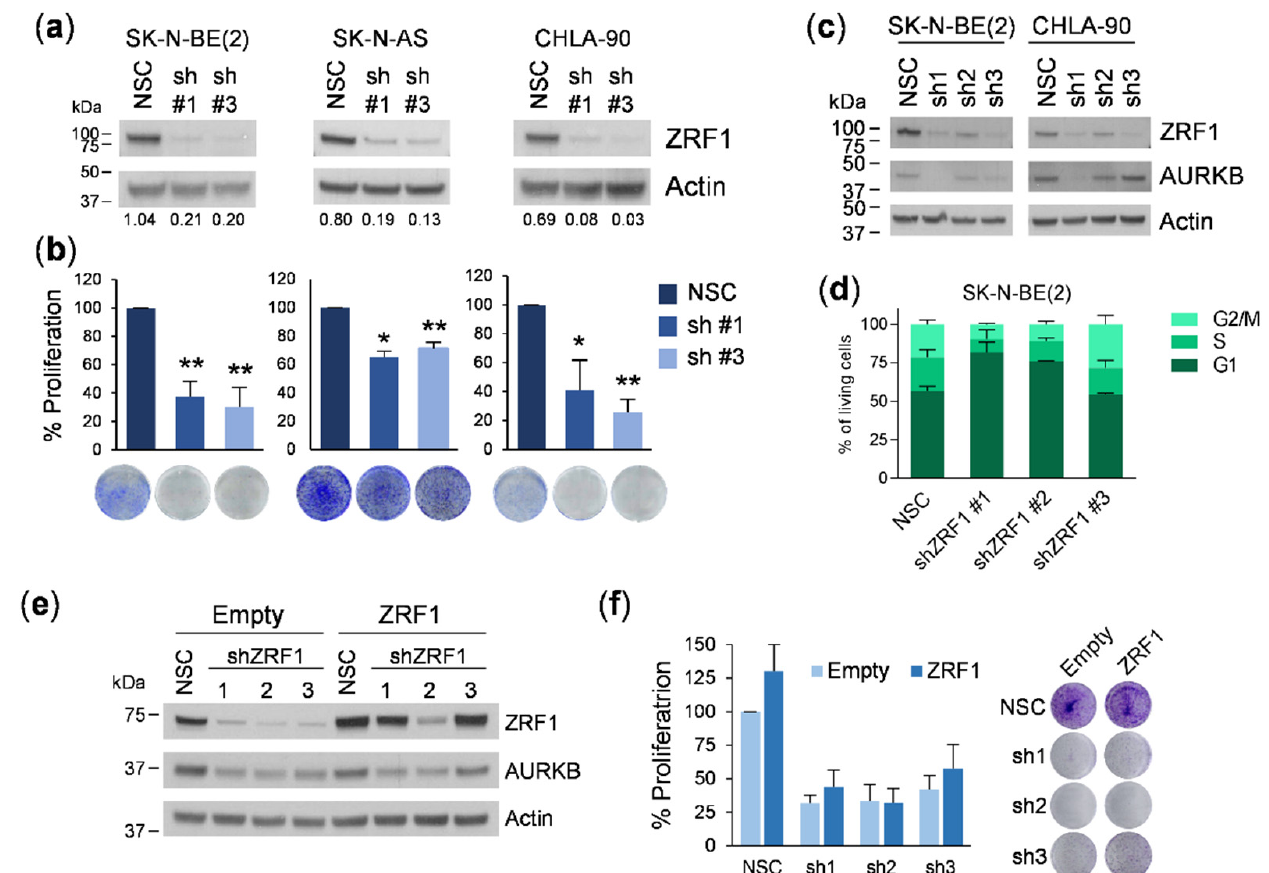
Figure 5. ZRF1 shRNA silencing results in inconsistent and unspecific effects in neuroblastoma cells. ( a ) ZRF1 expression levels in neuroblastoma cells transduced with two different shRNAs against ZRF1 , and a non-silencing control (NSC) as negative control. ( b ) Cell proliferation in shZRF1-transduced neuroblastoma cell lines compared with those transduced with NSC, measured by crystal violet. ( c ) ZRF1 and AURKB levels of sh ZRF1 transduced neuroblastoma cell lines. ( d ) Cell cycle analysis of SK-N-BE(2) 72 h post-infection by FACS. ( e ) Western blot analysis of ZRF1 and AURKB levels in SK-N- BE(2) cells overexpressing ZRF1 insensitive to shZRF1, at 96h post-transduction. ( f ) Cell proliferation assay of SK-N-BE(2) cells overexpressing insensitive ZRF1 transduced with 3 shRNAs against ZRF1 . * means p < 0.05; ** means p < 0.01.